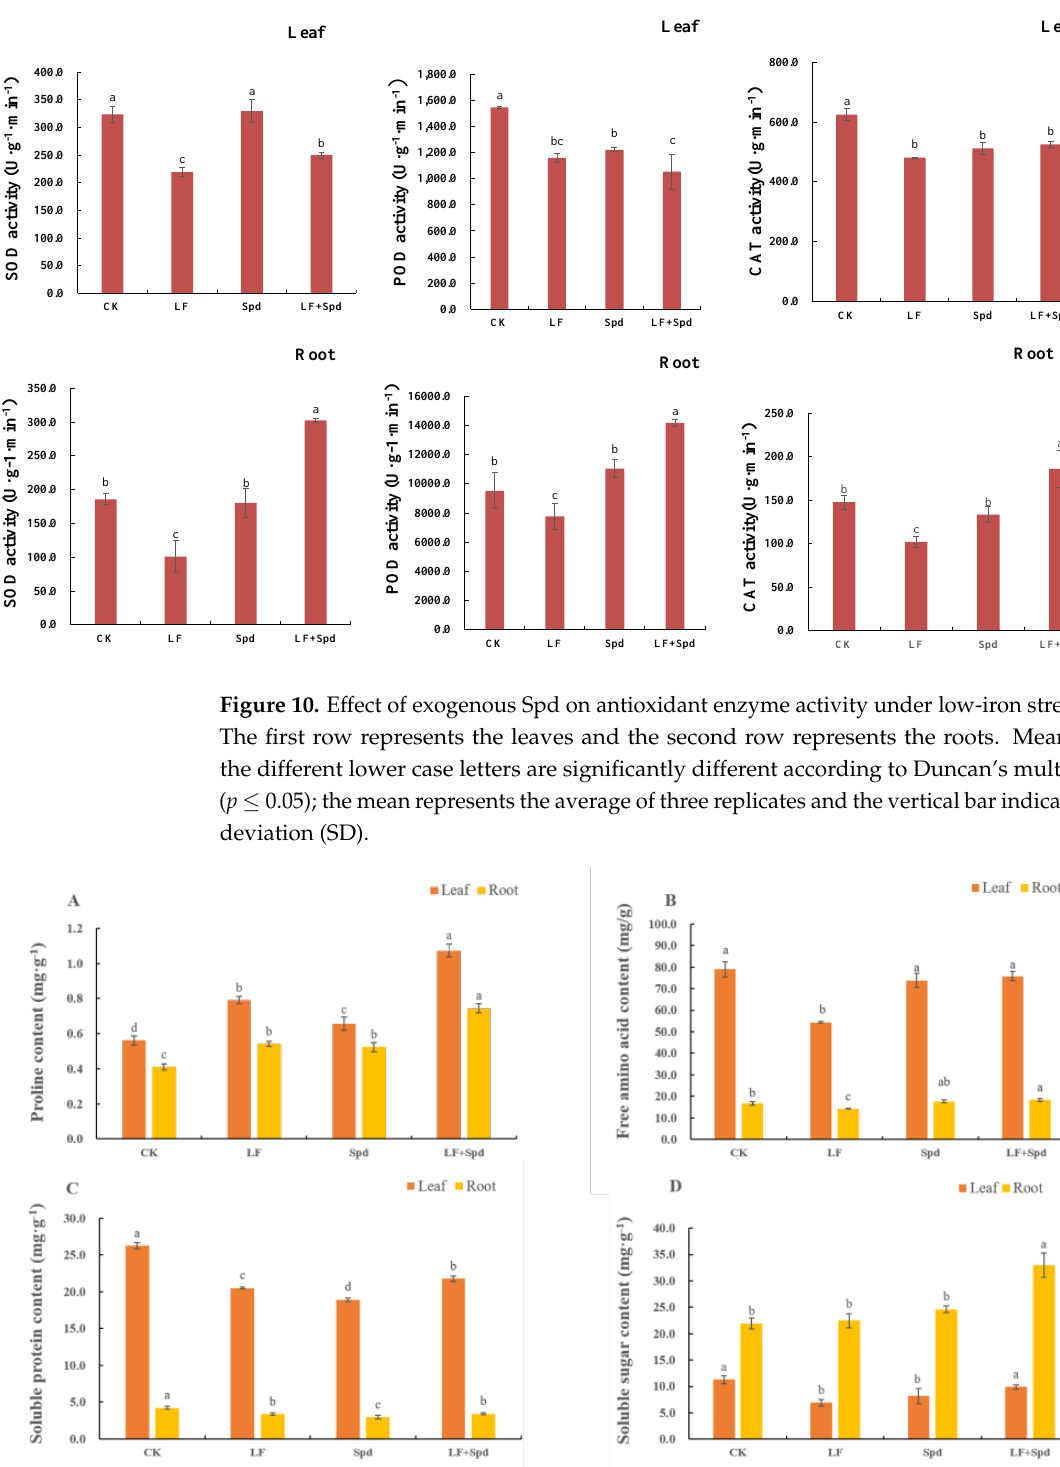
Figure 11. Effect of exogenous Spd on proline content, free amino acid content, soluble protein content and soluble sugar content under low-iron stress in tomato plants ( A – D ). Means denoted by the different lower case letters are significantly different according to Duncan’s multiple range test ( p ≤ 0.05); the mean represents the average of three replicates and the vertical bar indicates ± standard deviation (SD).